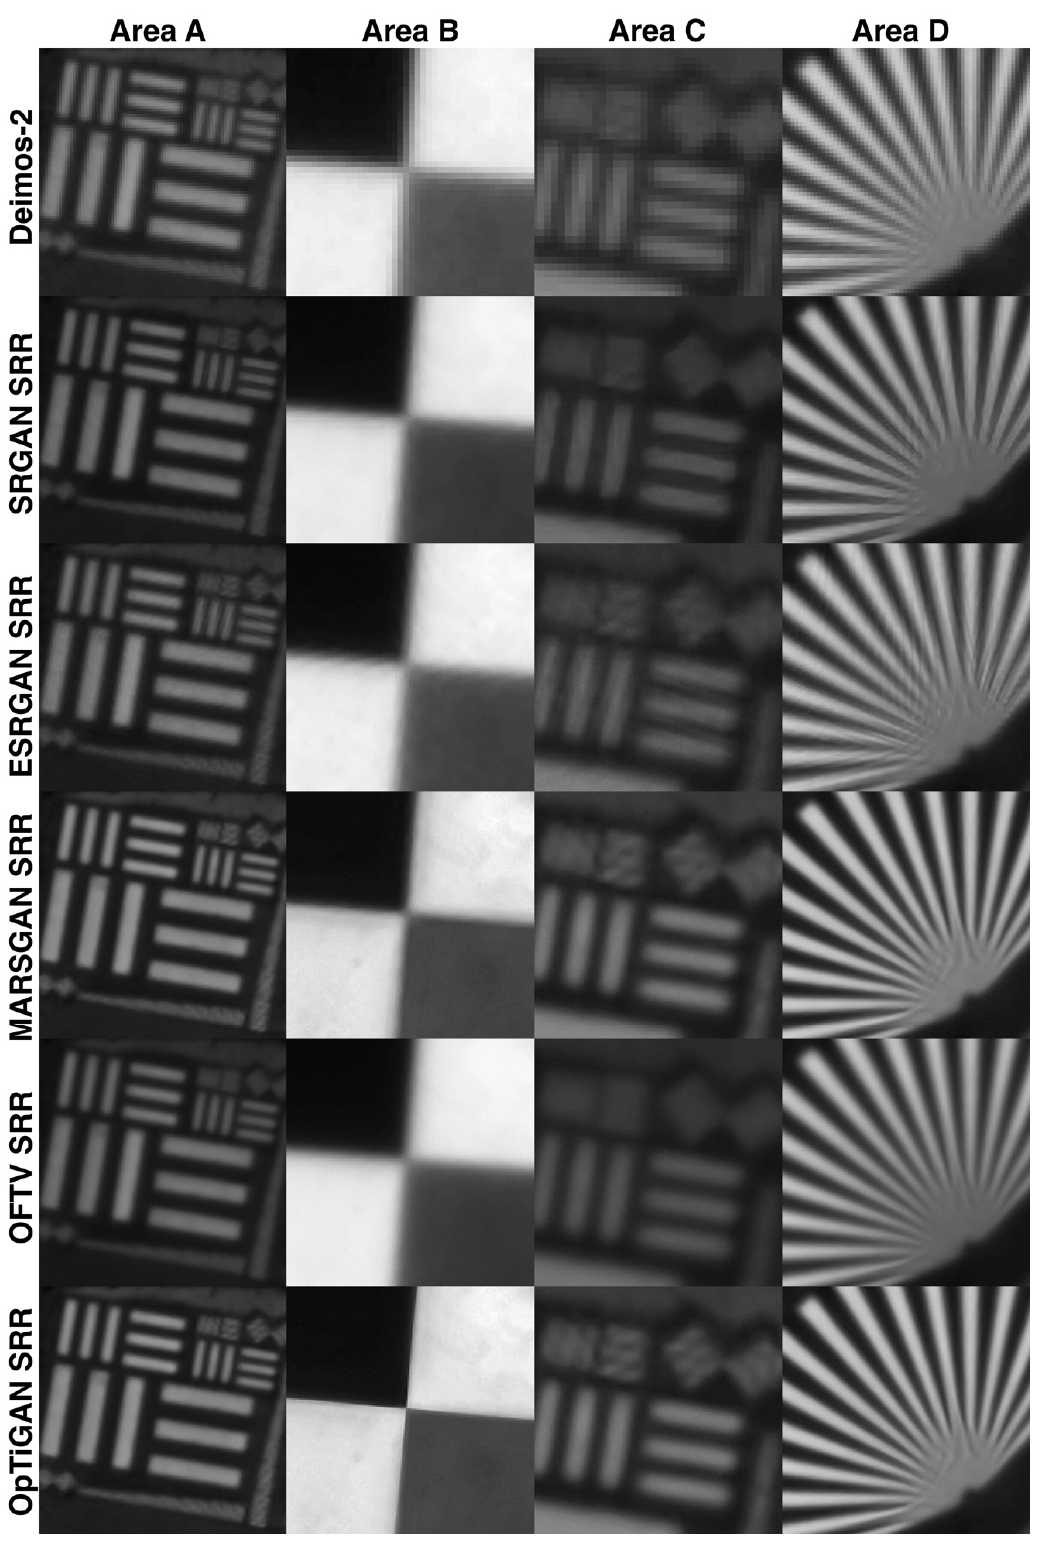
Figure 8. Deimos-2 SRR results, from SRGAN, ESRGAN, MARSGAN, OFTV and OpTiGAN, of four cropped areas on the bar-pattern target, knife-edge target and fan-shaped target, at the Baotou Geocal site. Please refer to the Supplementary Material for full-resolution images with larger size. Deimos-2 image courtesy of Deimos Imaging, S.L. 2021.